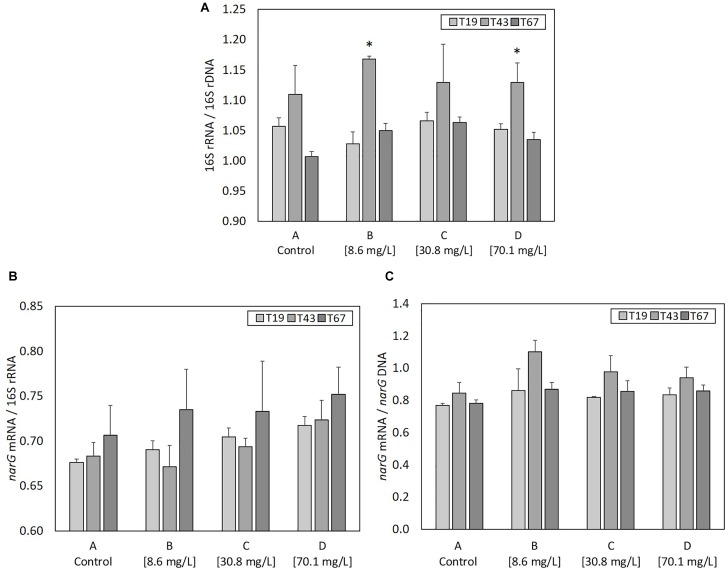
Parameters linked to bacterial activity at T19 (before nZVI addition) and at T43/T67 (i.e., after nZVI addition): (A) 16S rRNA/16S rDNA (bacterial community growth state), (B)
narG mRNA/16S rDNA (nitrate reduction activity of the bacterial community), and (C)
narG mRNA/narG DNA (nitrate reduction activity of nitrate-reducing bacteria over the bacterial community). ∗ Corresponds to a significant difference (P < 0.05, Student’s t-test) between T19 and T43 values, illustrating a significant impact of nZVI addition.